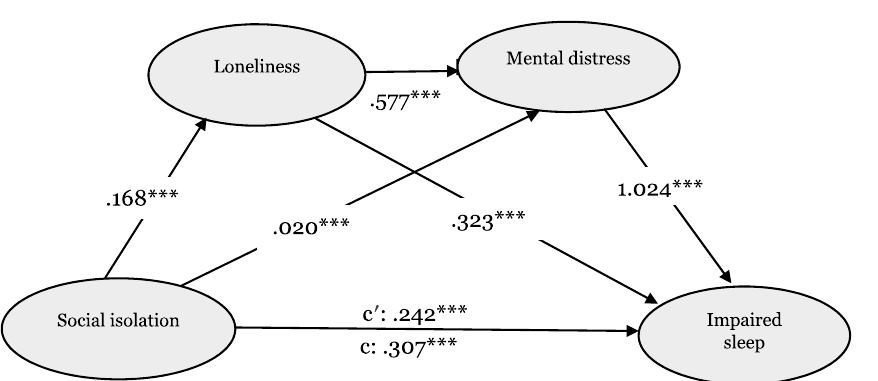
Figure 3. A serial multiple mediation model of the association between social isolation and impaired sleep through loneliness and mental distress. Path unstandardized coefficients are depicted. C ′ denotes the direct effect of social isolation on impaired sleep; c denotes the total effect of social isolation on impaired sleep via mediators.